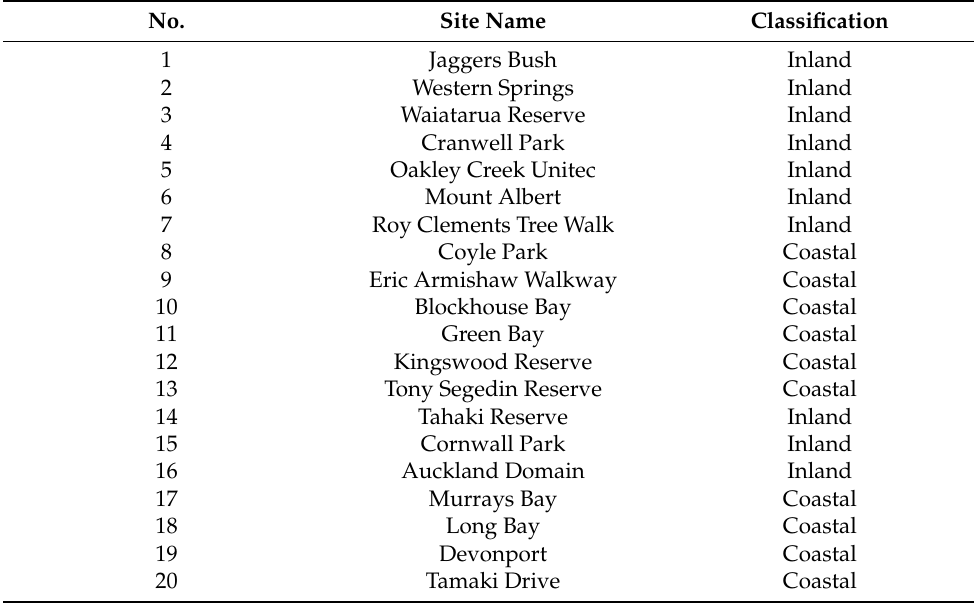
Table 1. Lichen sampling sites in Auckland, New Zealand and their classification.